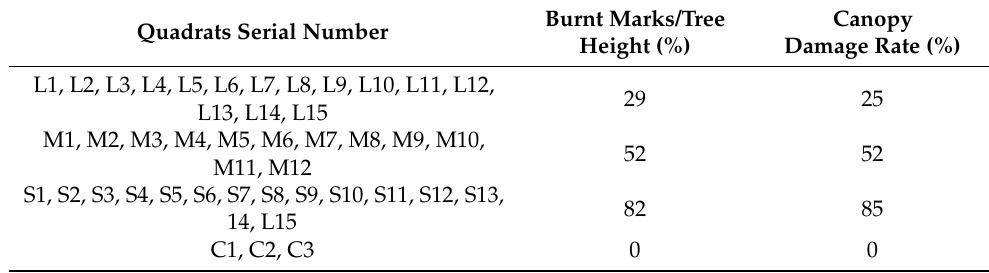
Table 1. The classification of fire severity (L: lightly burned areas, M: moderately burned areas, S: severely burned areas, C: control groups).